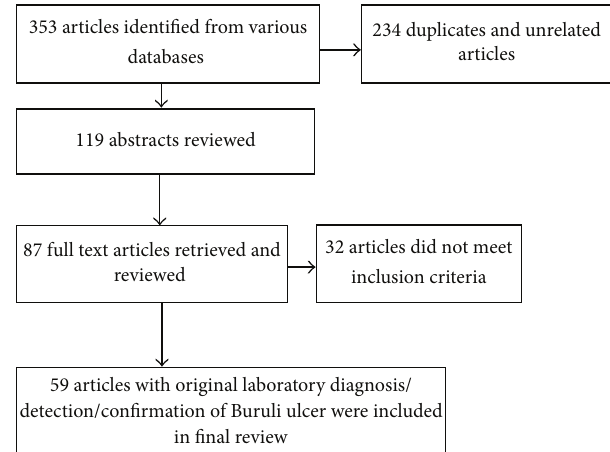
Figure 1: Schematic selection of review